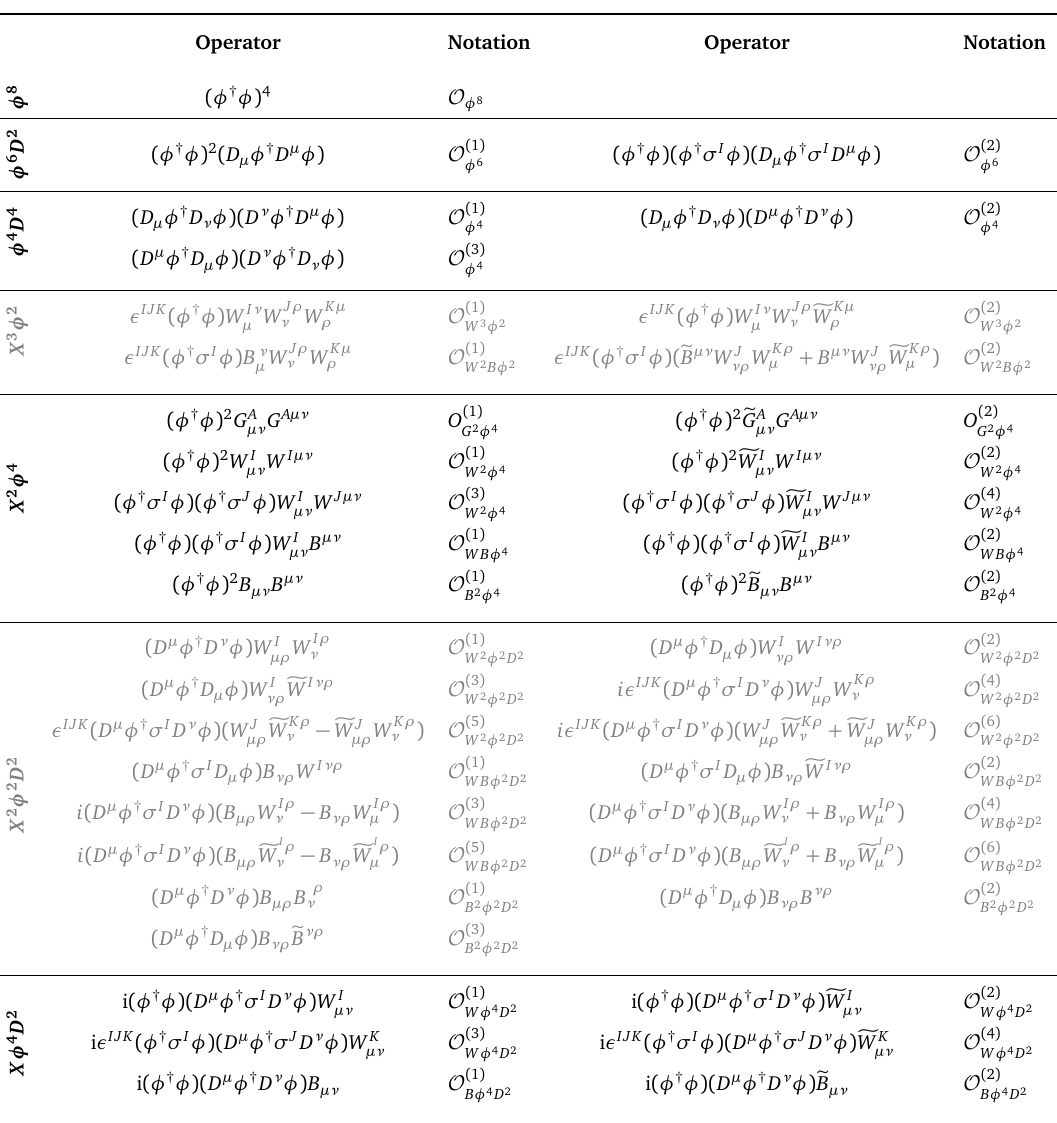
Table 1: Basis of bosonic dimension-eight operators involving the Higgs. We fol- low the notation from Ref. [ 17 ] . All interactions are hermitian. The operators in grey arise only at one loop in weakly-coupled renormalisable UV completions of the SM [ 29 ]